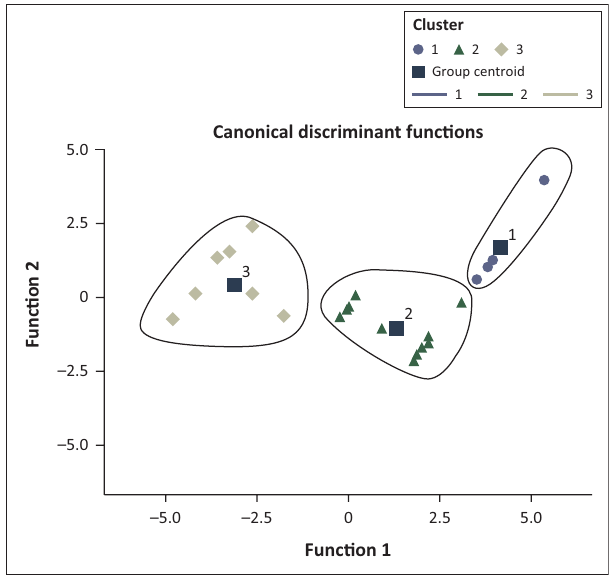
FIGURE 6: Canonical discriminant function